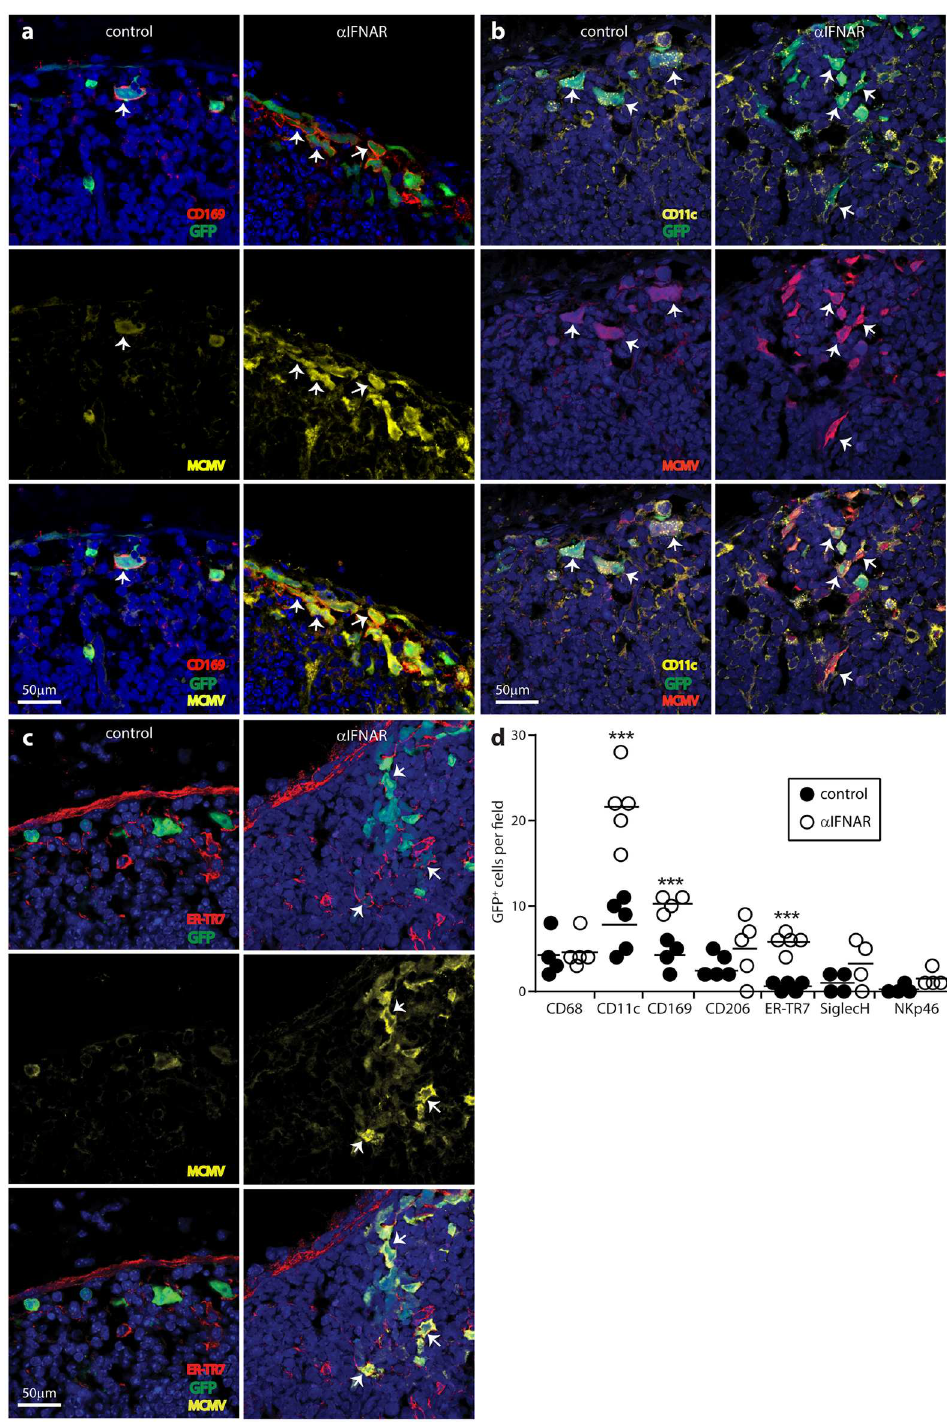
Fig 3. IFNAR blockade increasesSSM and FRC infections. C57BL/6mice were given IFNAR blocking antibody ( α IFNAR) or not (control), then MCMV-GR i.f. (10 6 p.f.u.). PLN taken 1 day later were stained for viral GFP (GFP) and lytic antigens(MCMV), plus the SSM marker CD169( a ), the SSM/DC marker CD11c ( b ) or the FRC marker ER-TR7 ( c ). Nuclei were stained with Hoechst 33342 (blue). Arrows show exampleinfected SSM and FRC. Both were more numerous after α IFNAR. In ( d ) we counted cells across 4–5 fields of view for PLN sections from each of 3 mice per group. Circles show individualmeans, bars show group means.